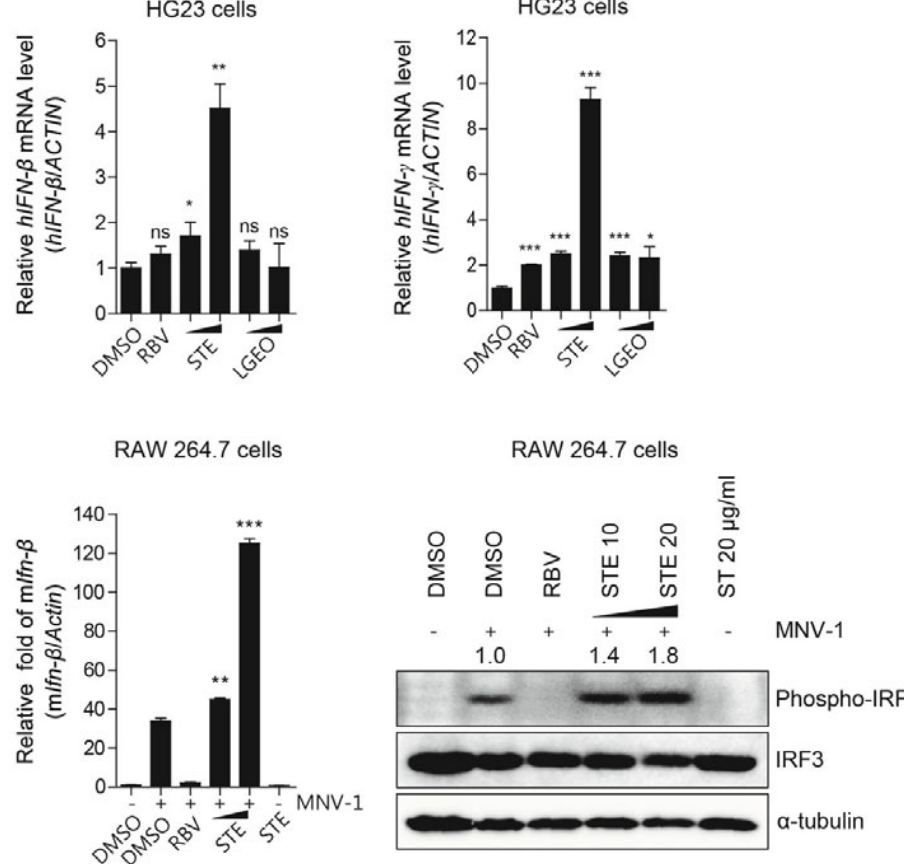
Figure 13. Induction of antiviral interferon production by STE during norovirus replication (* p < 0.05, ** p < 0.01, *** p < 0.001 versus control ( t -test)) [65]. (Detailed information can be found in Figure 4 of